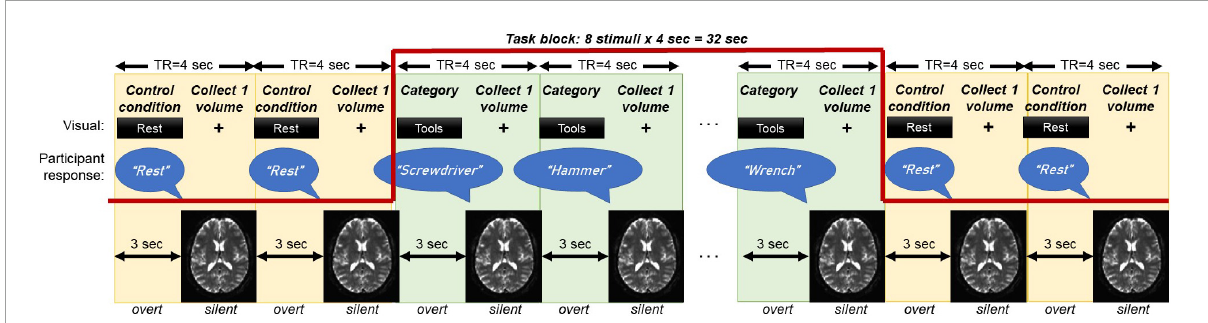
FIGURE1 Schematic of the overt category member generation (i.e., semantic fluency) task that has been optimized to fit a sparse-sampled MRI acquisition. The participant is visually presented a category for 3 s, during which they generate a novel exemplar of that category. During the category presentation, no MRI data is collected (effectively a TR gap). During the MRI data collection, the screen switches to a “+” fixation cross for 1 s, during which the participant is silent and still to reduce the influence of motion. One block contains 8 stimuli (32 s). To control for activation from speech, the task block is flanked by presentations of the word “Rest,” during which the participant also says the word “Rest.” Three runs of 6 blocks are collected, for a total of 3 × 6 × 8 = 144